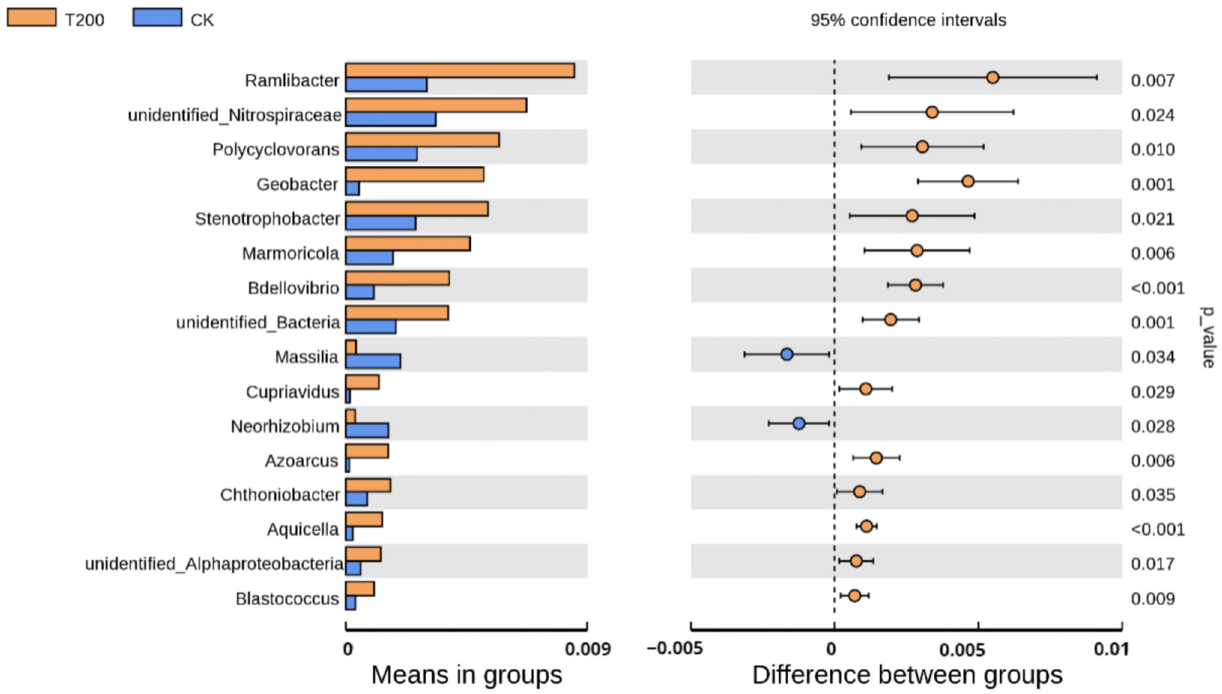
Figure 2. Differences in the relative abundance of bacterial community at genus level among dif- ferent treatments. The left panel shows the relative abundance of differentially abundant bacterial communities under the two treatments. The right panel shows the p -value as the ordinate and the significant difference as the abscissa.